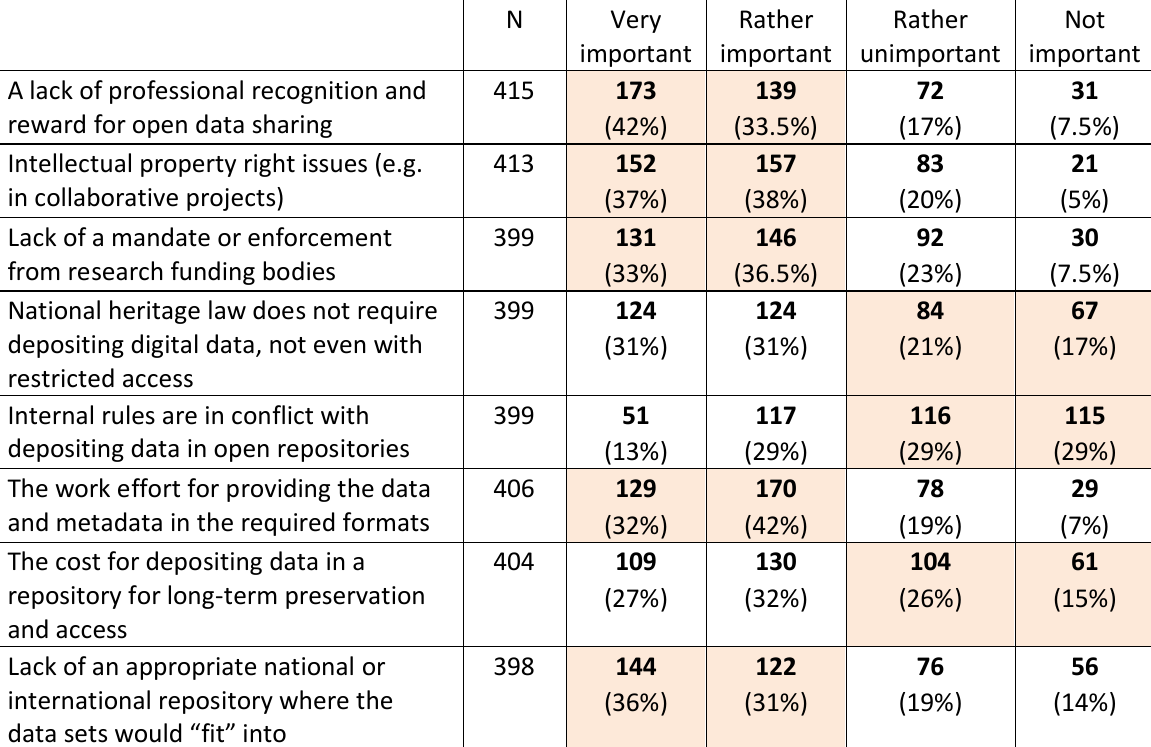
Table 10 : Barriers for data deposition and sharing (N =